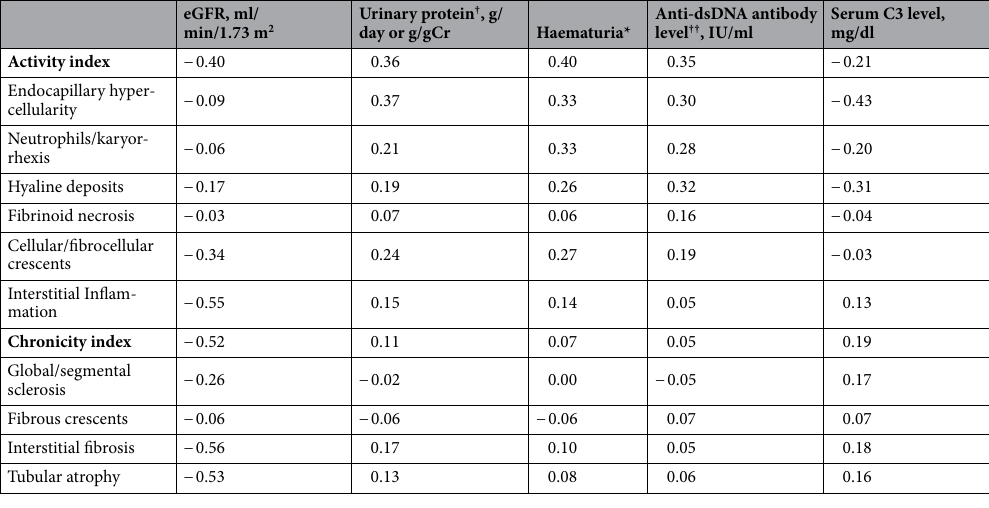
Table 2. Correlations between the baseline characteristics and pathological findings. Correlations between the baseline clinical data and pathological scores are described by using Spearman correlation coefficients. eGFR